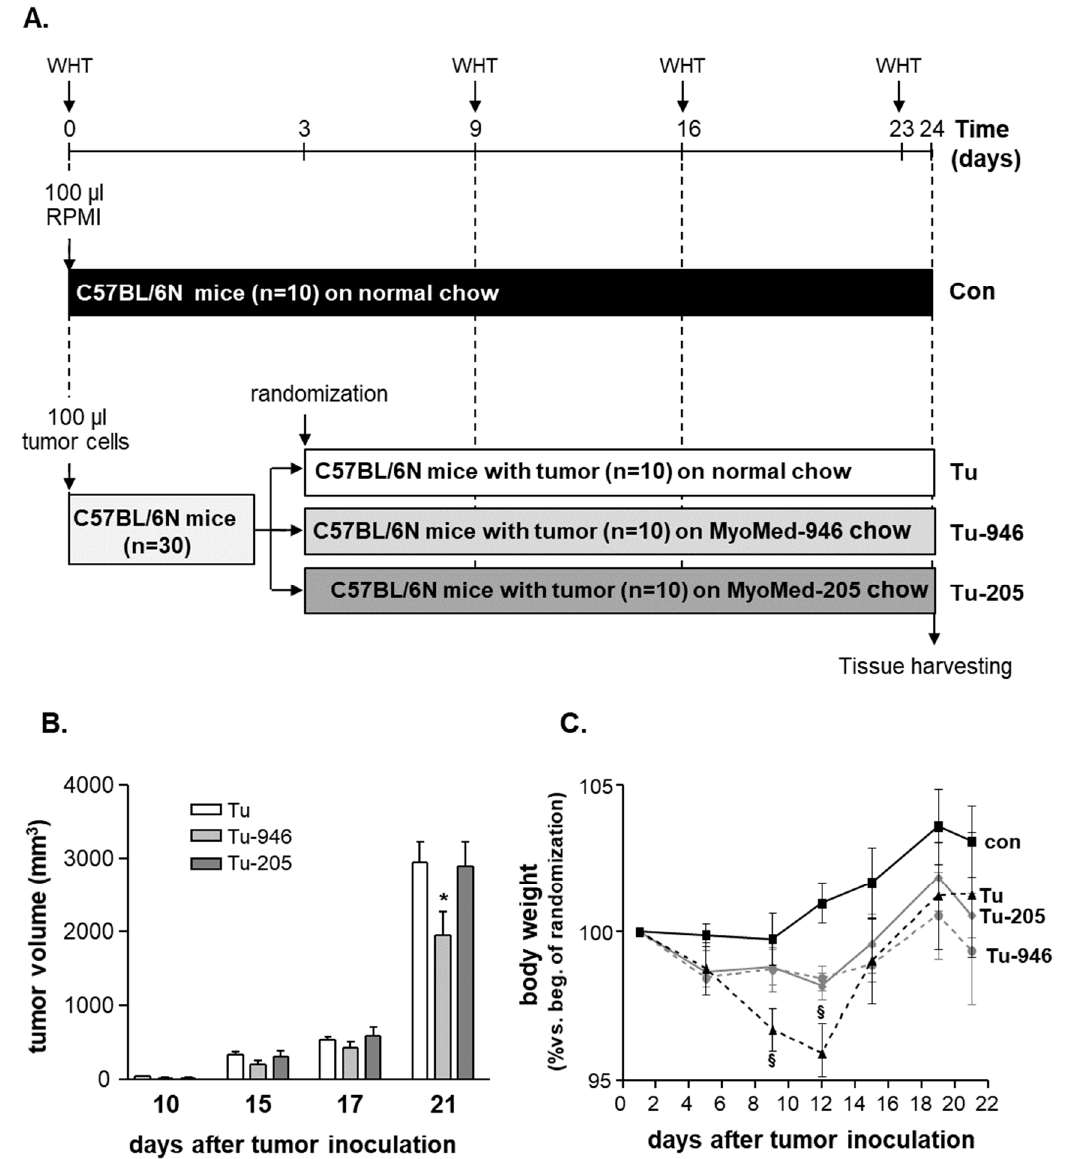
Figure 1. Study design for inducing melanoma tumor growth followed by monitoring cancer cachexia ( A ). Thirty mice were injected with 5x105 melanoma cells (B16F10 cell line). As controls, ten mice were injected with RPMI medium only without tumor cells (con). The B16F10 inoculated mice were randomly assigned on day 3 to study groups either receiving standard diet during melanoma outgrowth (Tu), or received food supplemented with Myomed-946 (Tu-946), or receiving chow supplemented with Myomed-205 (Tu-205), respectively. Wire hang tests (WHTs) were performed at days 9, 16, and 23. Mice were sacrificed at day 24 for dissections. Tumor growth was monitored non-invasively by caliper measurements ( B ) and animal weights ( C ) were assessed. Values are shown as mean ± standard error of the mean, * p < 0.05 vs. Tu at the same time point, § p < 0.05 vs. con at the same time point. For Western blot analyses, frozen EDL was homogenized in Relax bu ff er (90 mmol /